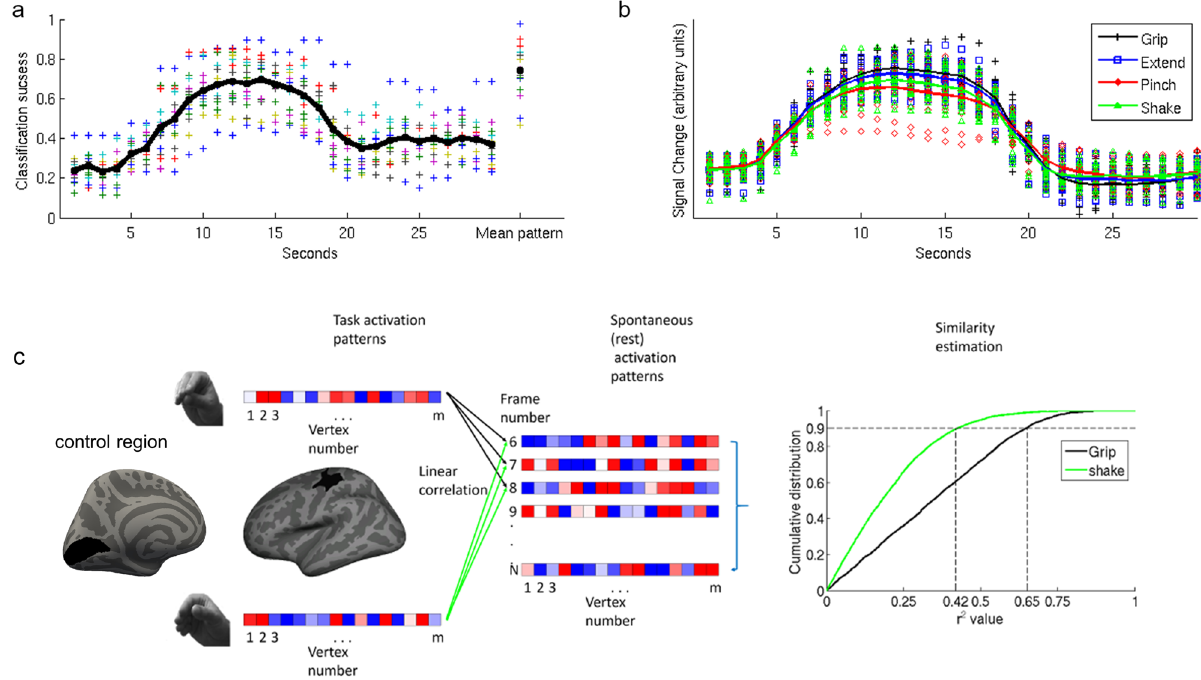
Figure 2. (a) Classification performance through a linear discriminant analysis indicated that the classification performance between the different hand movements through the pattern of motor activation at each TR followed the hemodynamic response function with a gradual increase in performance starting ~ 6 s after trial onset (spearman r between the mean classification function and the mean BOLD signal representing a full trial, combining all the conditions together, is 0.876). The rightmost data points represent classification performance based on the mean activation patterns constructed by averaging the patterns of the frames starting 10 s after trial onset and ending at 18 s after trial onset. Different colors represent different participants, the black trace represents mean classification levels across participants. Chance level of correct classification was 0.25. For presentation purposes only, each data point of the two participants who were scanned using a 2 s TR was duplicated in the figure (TR #1 is presented as second 1 & 2, etc.). (b) Mean BOLD time course for the four hand movement conditions. Each data point represents the mean normalized BOLD signal change of each participant to her baseline BOLD activity across all ROI vertices in a specific time point during the block. The solid lines represent the mean normalized BOLD signal change across participants corresponding to each hand movement. For presentation purpose only each data point of the two participants who were scanned using a 2 s TR was duplicated in the figure. (c) A spatial pattern was defined for each hand movement in the participant- defined motor ROI. Each of the four task patterns were compared to the spatial pattern of the same vertices in each rest frame using Pearson correlation. For each pattern, we computed the cumulative distribution function (CDF) of r 2 values across all rest frames. In each CDF of each participant we calculated the value corresponding to the 90th percentile of that function (vertical dashed lines). This value was used to estimate the degree of representation of the specific pattern in the rest data. The same analysis was performed in a control ROI, the primary visual